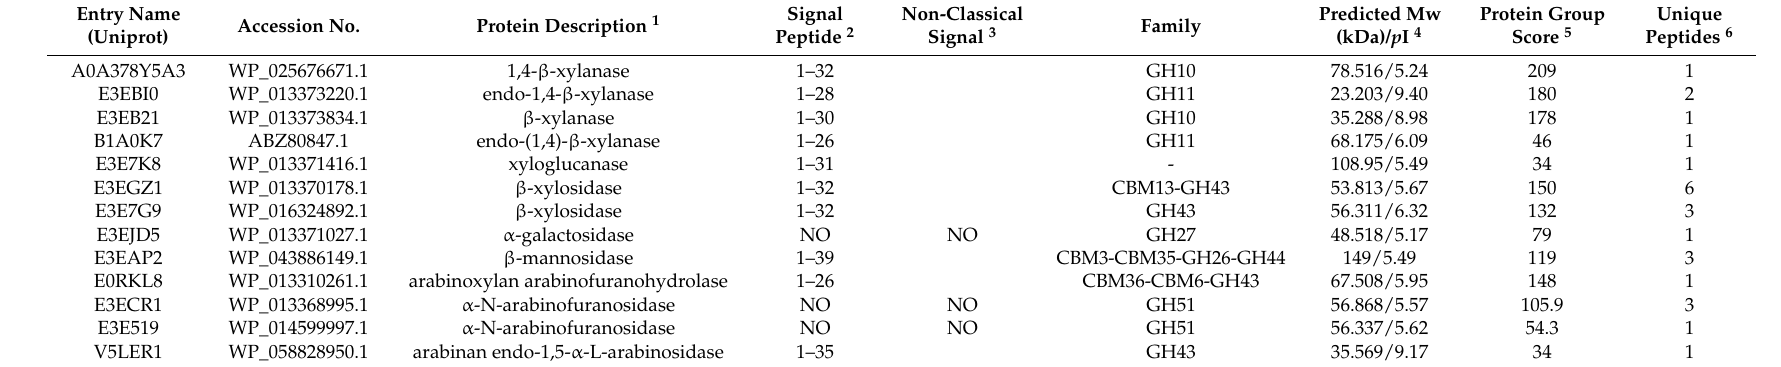
Table 2. Hemicellulose-degrading enzymes obtained by LC-MS/MS